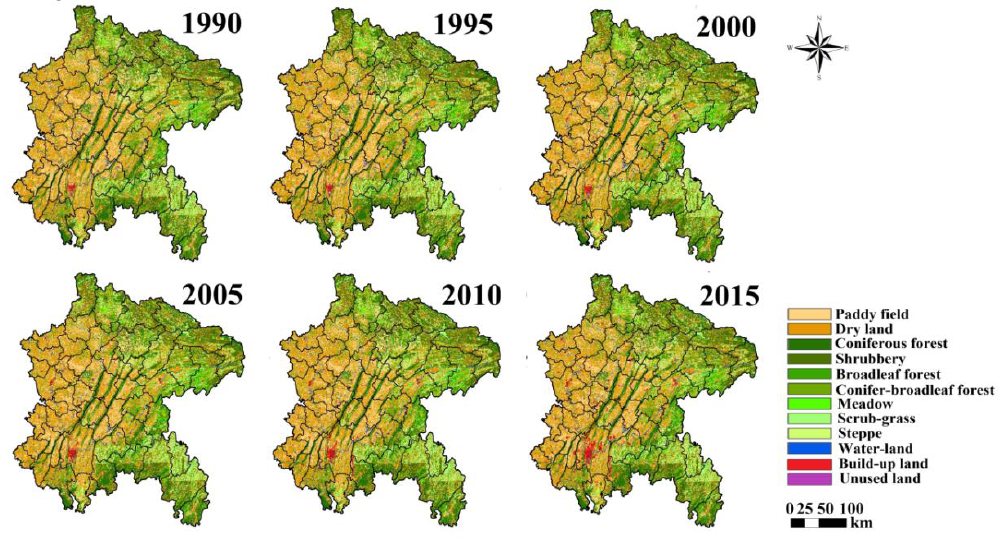
Figure 2. The land use types in this study area.